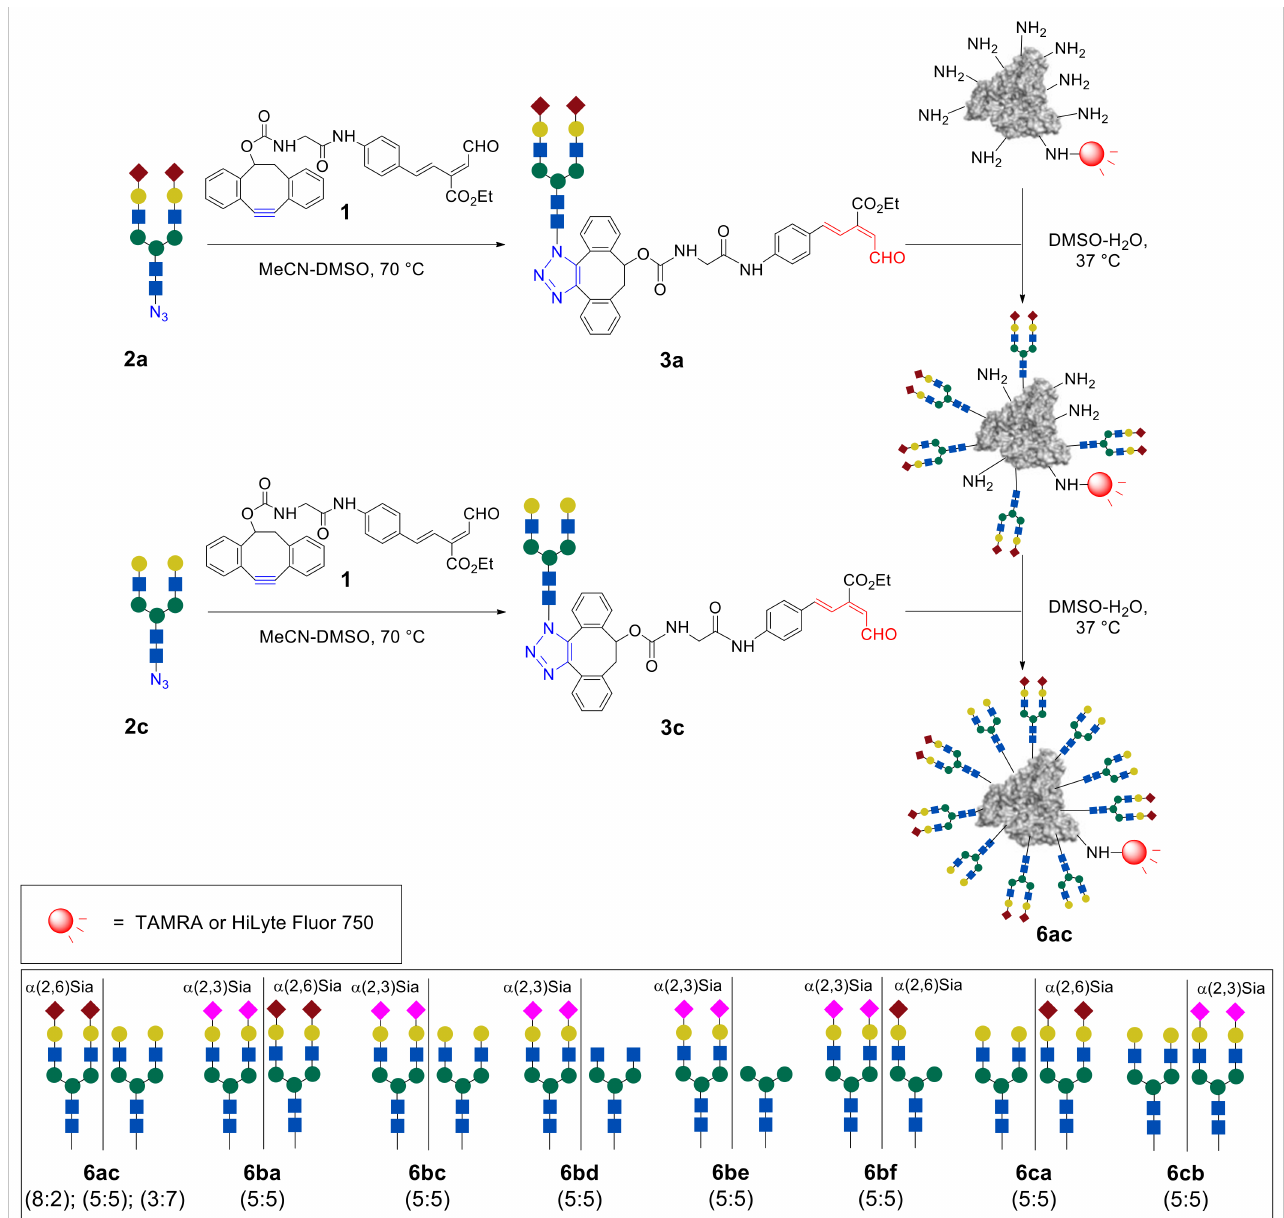
Figure 6. Synthesis of heterogeneous arbitrarily arranged glycoalbumins 6 by sequential immobiliza- tion of glycan–aldehydes 3 : representative synthesis of heterogeneous glycoalbumin 6ac ; synthesized glycoalbumins 6 (numbers in parentheses represent the ratios and order of the introduced gly- cans)